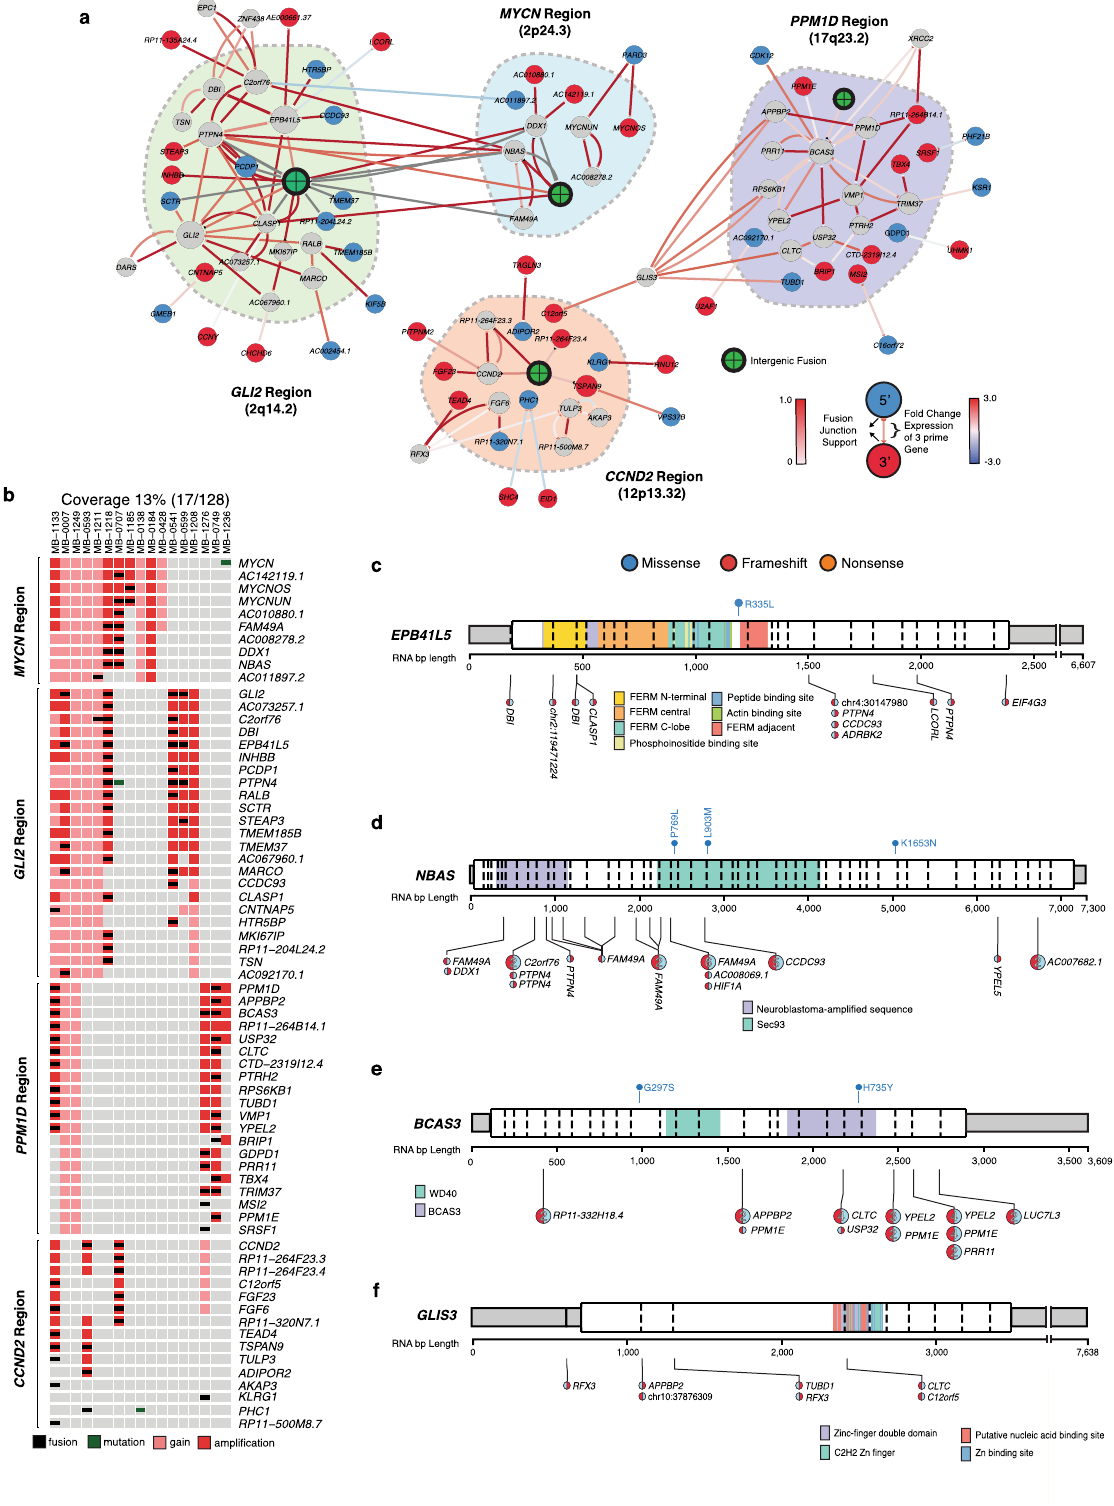
Fig. 5 Fusion networks within somatic recurrently ampli fi ed regions. a The network of gene fusions in focally ampli fi ed regions. Node color signi fi es the most common orientation of the fusion gene, 5 prime (blue), 3 prime (red), or both (gray). The arrow and base color show the proportion of chimeric reads compared to wildtype supporting the fusion. The arrow line color shows the difference in expression of the 3 prime fusion partners compared to patients without the detected fusion. b Oncoprint of fusions depicted in focally ampli fi ed regions illustrated in a . c – f Gene-level summary of ( c ) EPB41L5 , ( d ) NBAS , ( e ) BCAS3 , and ( f ) GLIS3 events. Refer to Fig. 2b for schema